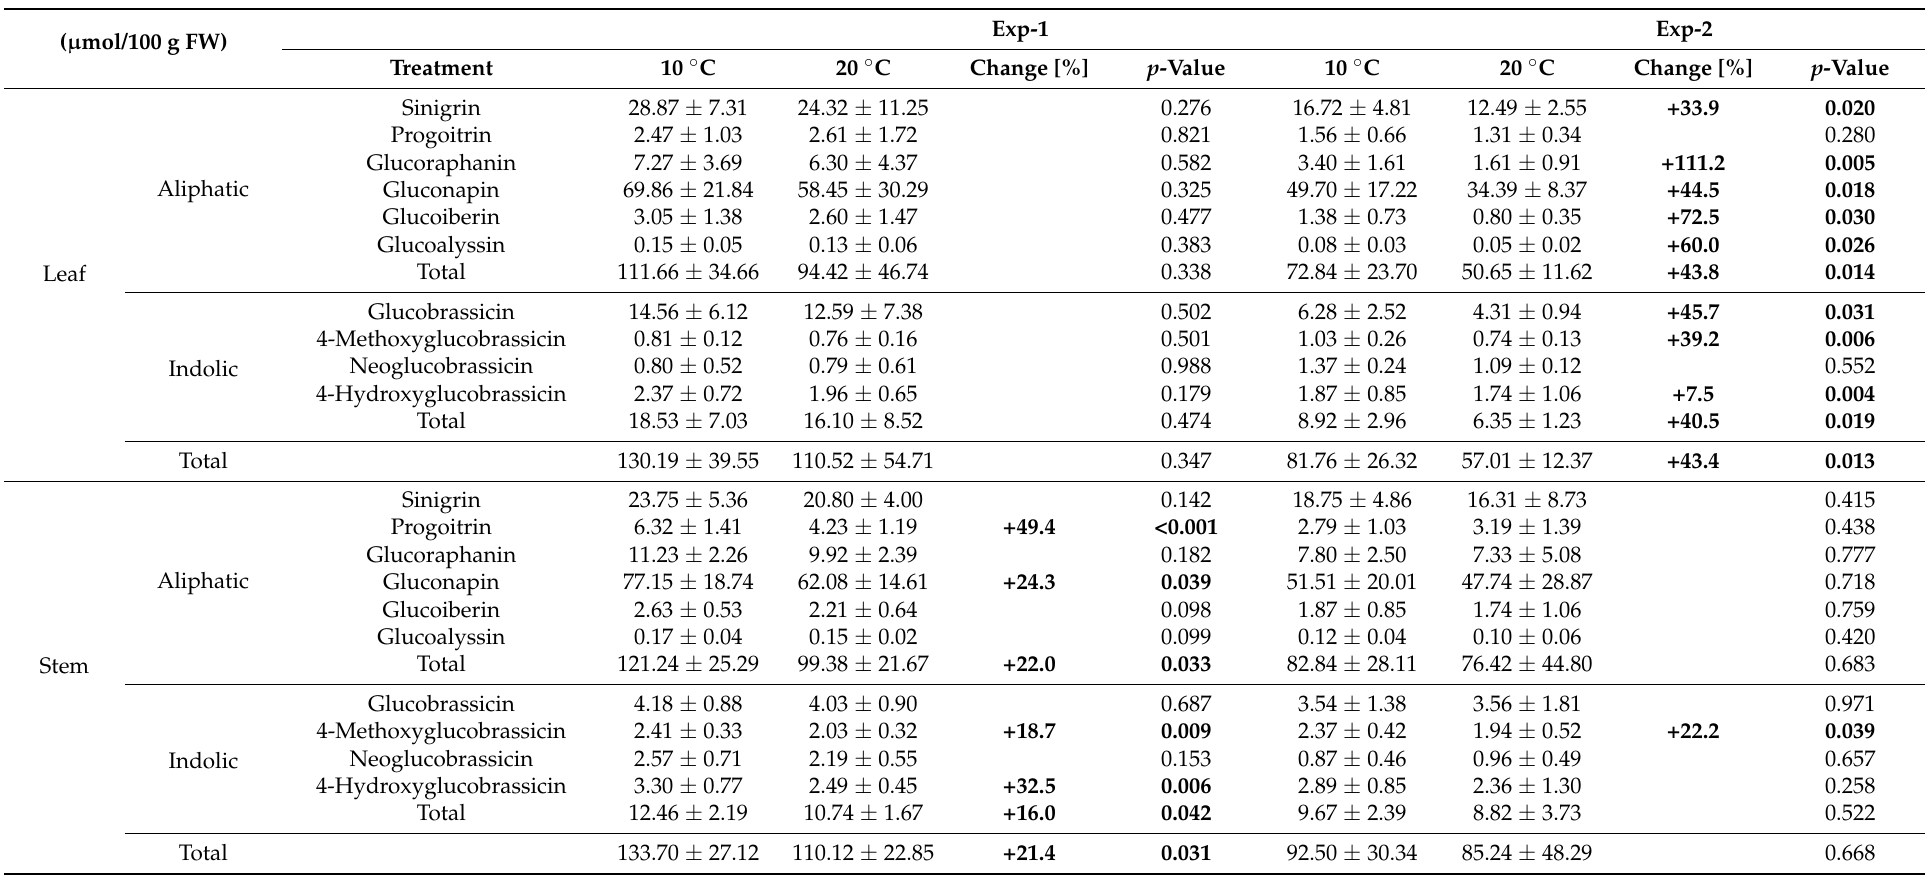
Table 4. Total, aliphatic, indolic and individual glucosinolates concentrations ( µ mol/100 g FW) in the leaves and stems of Chinese broccoli under different root temperatures and harvest dates in Exp-1 and Exp-2. Significant differences ( p < 0.05) were indicated in bold. FW: fresh